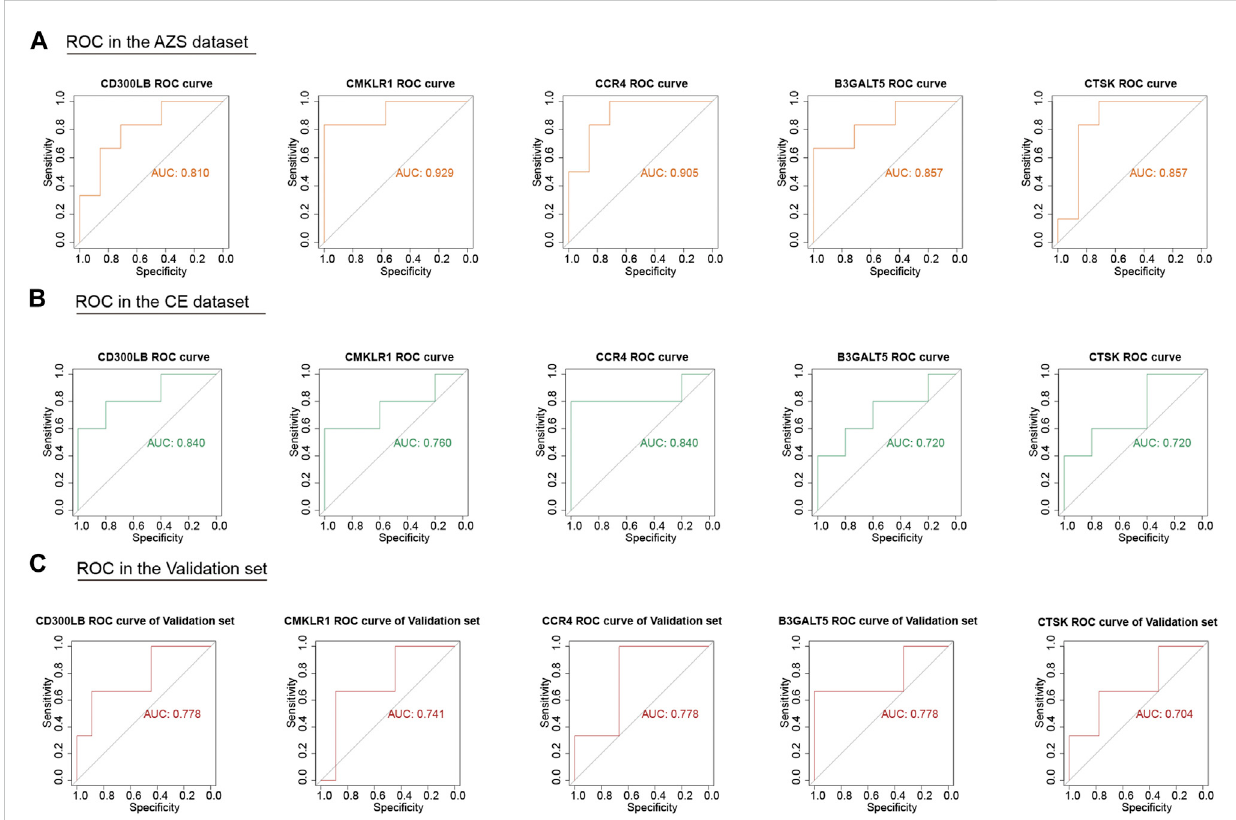
ROC analysis of fi ve hub genes ( CD300LB, CMKLR1, CCR4, B3GALT5, and CTSK ) in the AZS, CE, and validation dataset. (A) ROC analysis of fi ve hub genes in the AZS dataset. (B) ROC analysis of fi ve hub genes in the CE dataset. (C) ROC analysis of fi ve hub genes in the validation set (GSE26881).